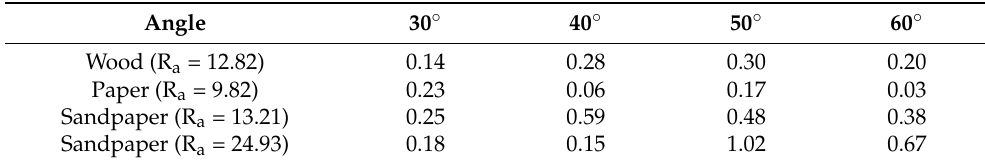
Table 1. Differences between backward and forward friction coefficients ( µ S.forward − µ S.backward ) according to snake scale structure angle.